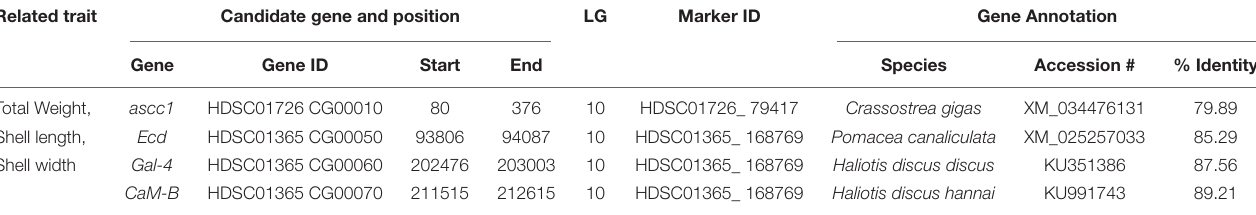
TABLE 8 | Summary of candidate genes identified by QTL mapping of growth-related traits in Pacific